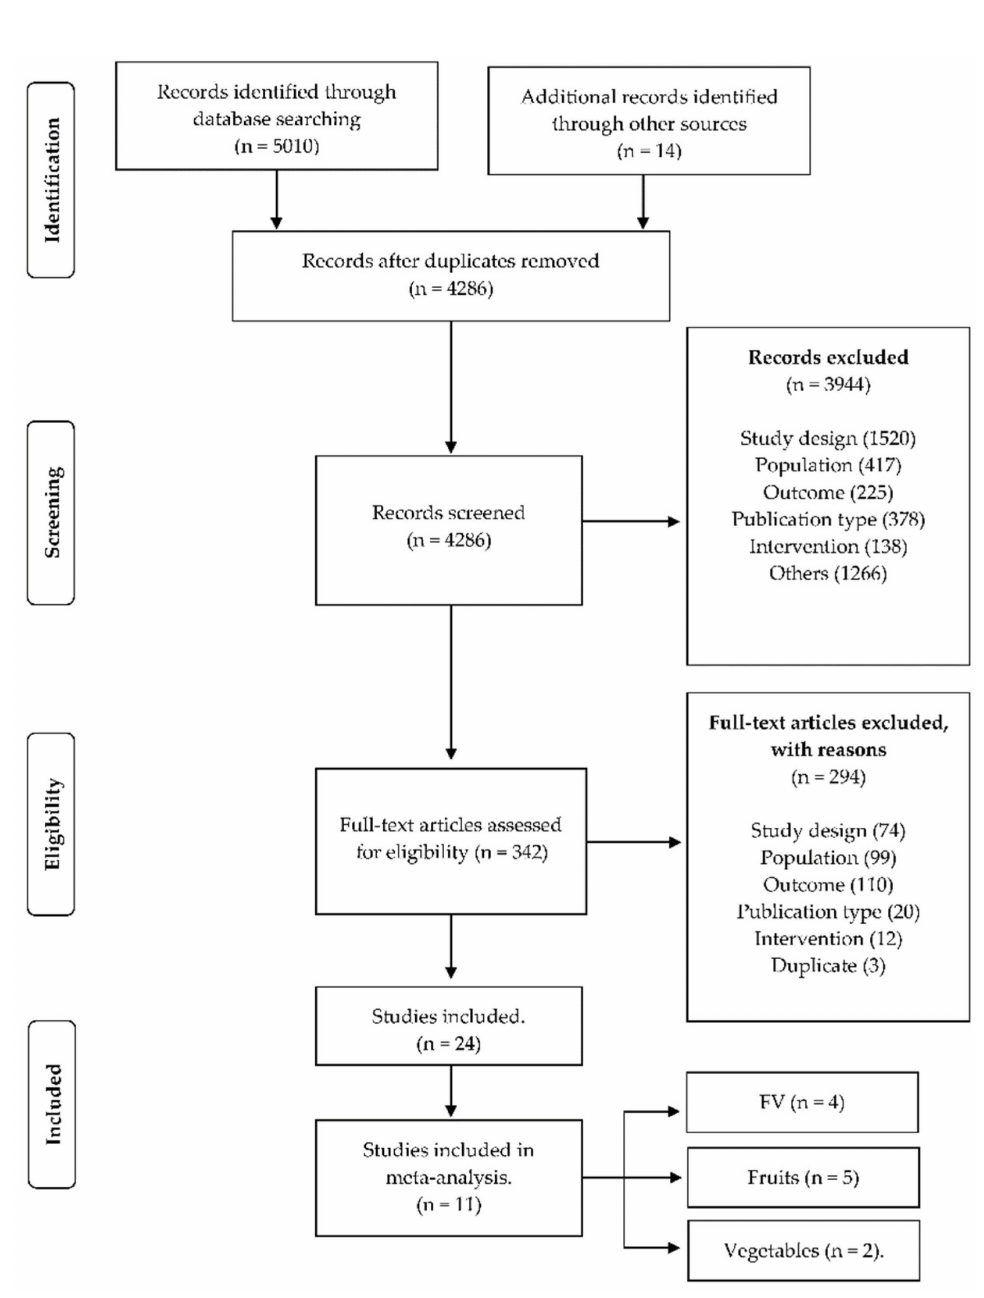
Figure 1. PRISMA flowchart of study